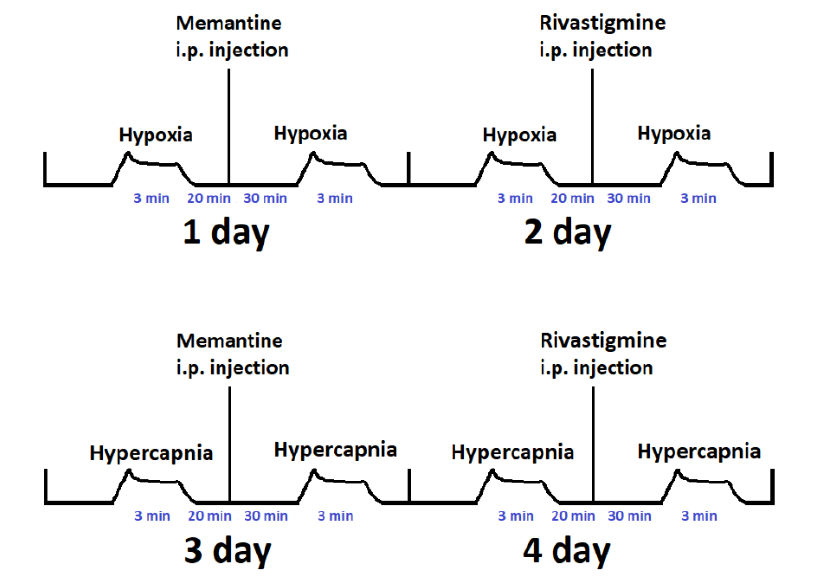
Figure 7. A detailed description of the stimulus exposures (hypoxia or hypercapnia) and compound administration performed (memantine or